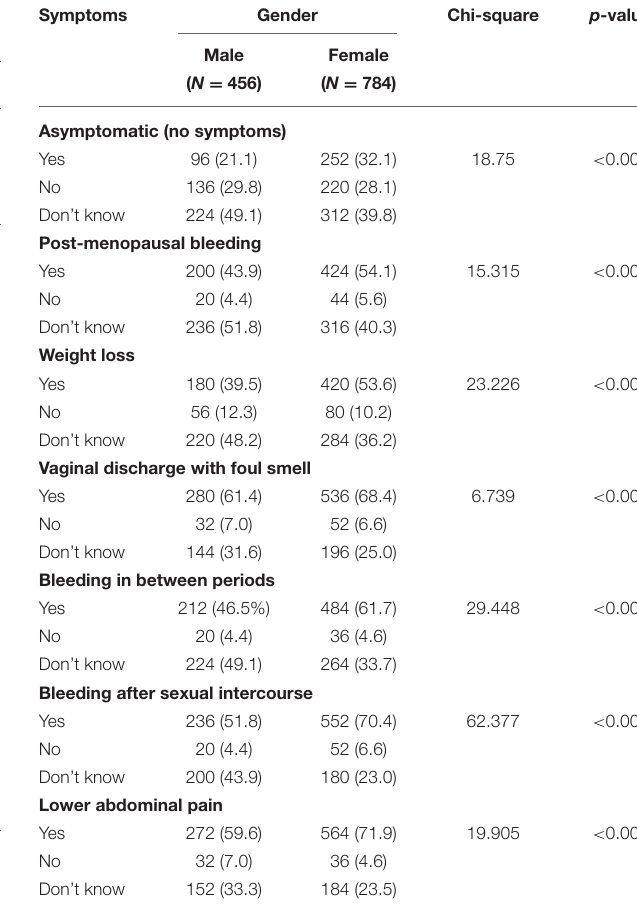
TABLE 3 | Knowledge on cervical cancer symptoms answered by only participants who have heard of cervical